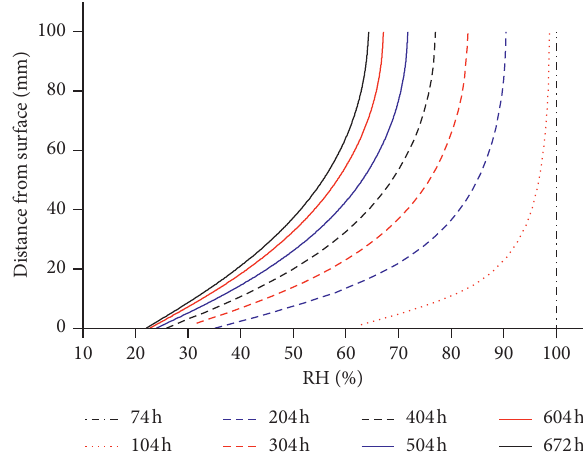
Figure 8: Humidity gradient of drying